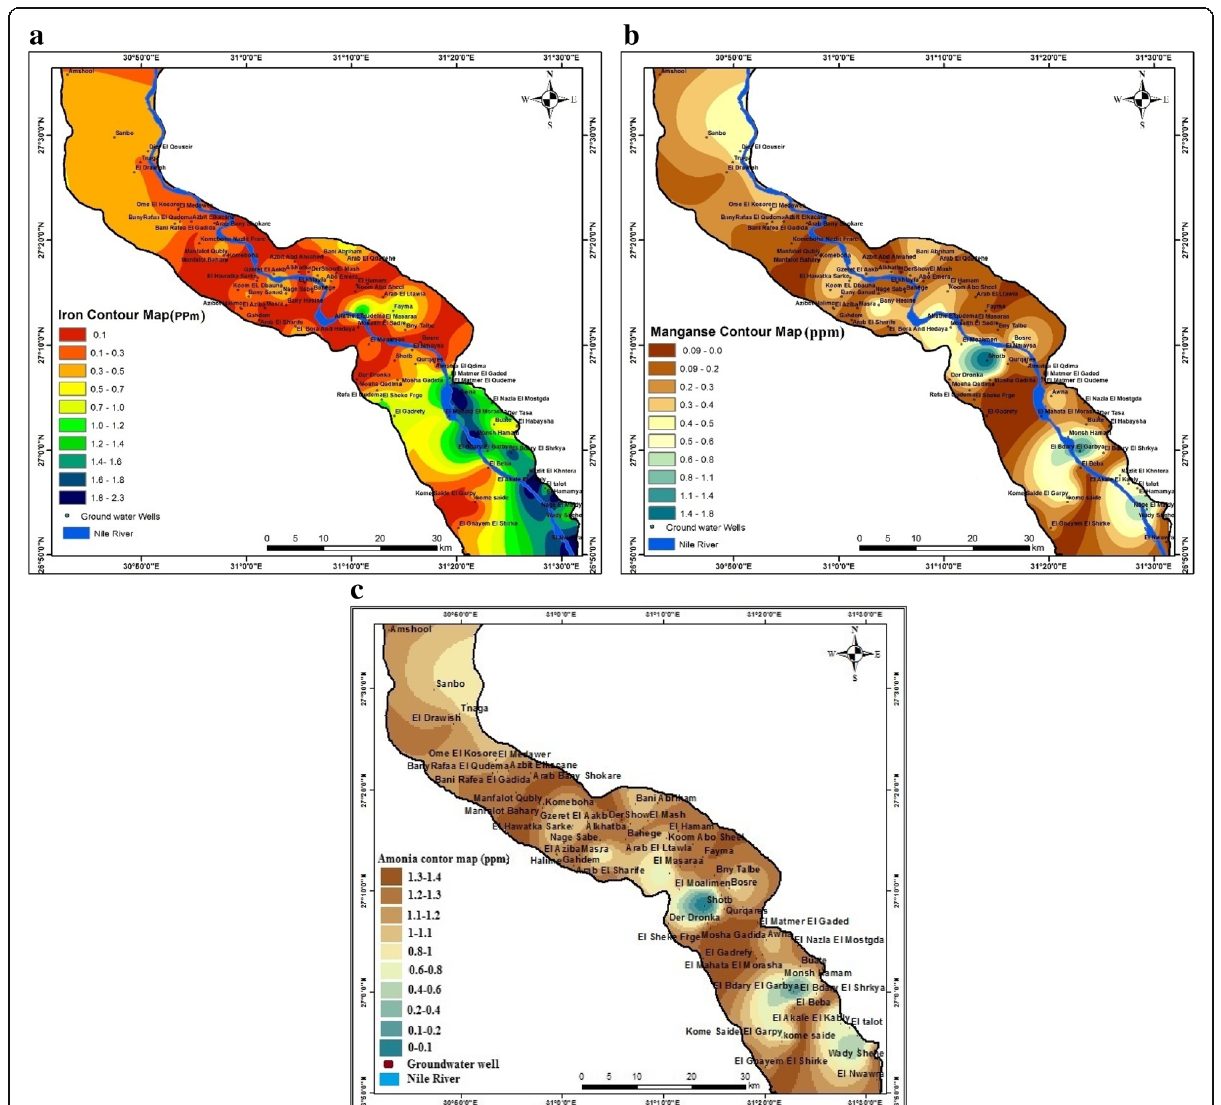
Fig. 12 Iso-concentration maps showing spatial variation in a Fe, b Mn, and c NH 3 in the study area (value in milligrams per